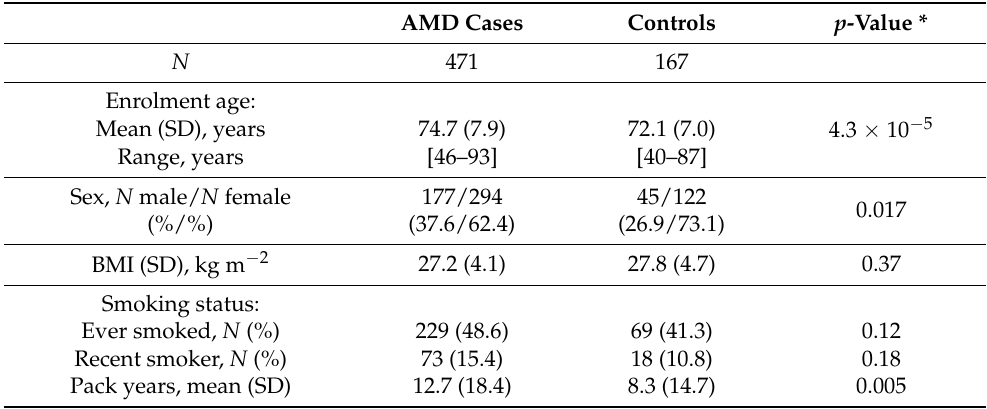
Table 2. Characteristics of participants of the age-related macular degeneration study. (*) Mann- Whitney test/Chi-squared